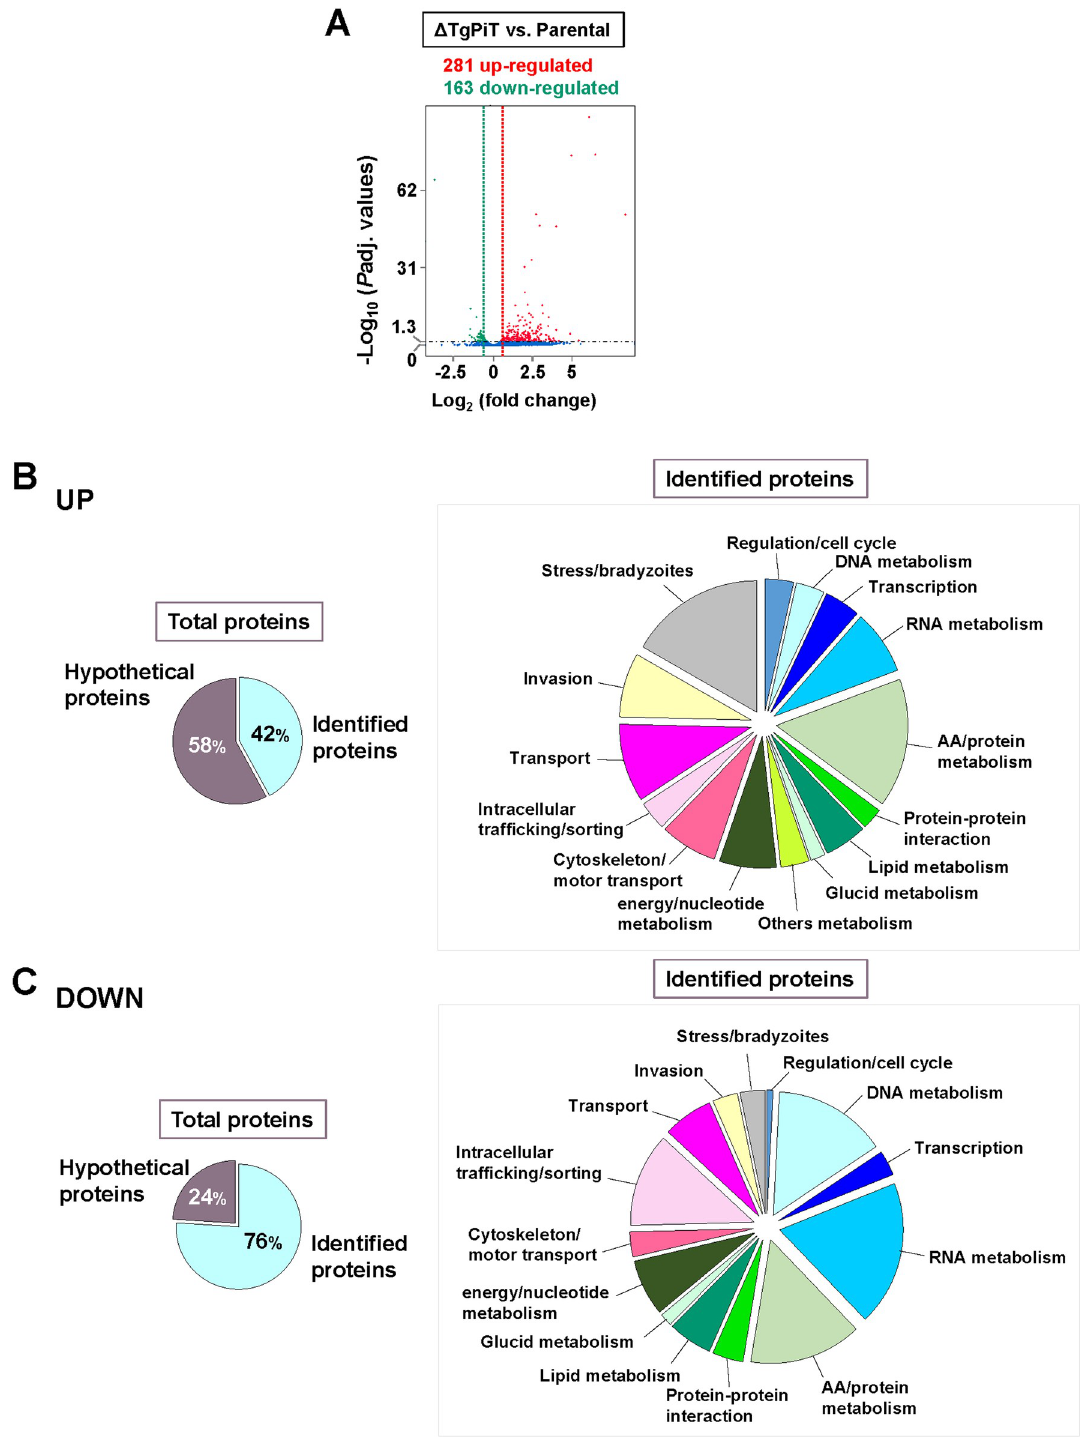
Fig 13. RNA-Seq comparison between Δ TgPiT and parental parasites. A. Volcano plot revealing 281 genes having increased expression (red) and 163 with decreased expression (green), with statistical significance less than 0.05 in the Δ TgPiT relative to the parental strain. The green and red dashed lines represent the borderline of Log 2 fold change of 0.4 in gene transcripts, and the genes above the black dashed line had padj values of statistical significance below 0.05. Each sample was sequenced in duplicate for statistical comparison. B-C. Left: Pie charts plotting the percent of proteins whose genes are up-regulated (in B) or down-regulated (in C), identified in the ToxoDB. Right: Pie charts categorizing the identified proteins based on their biological functions.